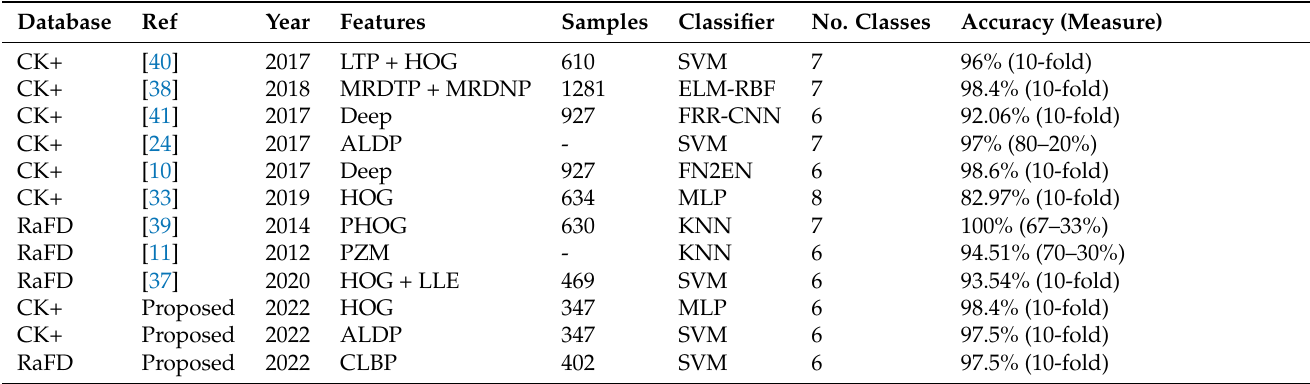
Table 8. Comparison with state-of-the-art